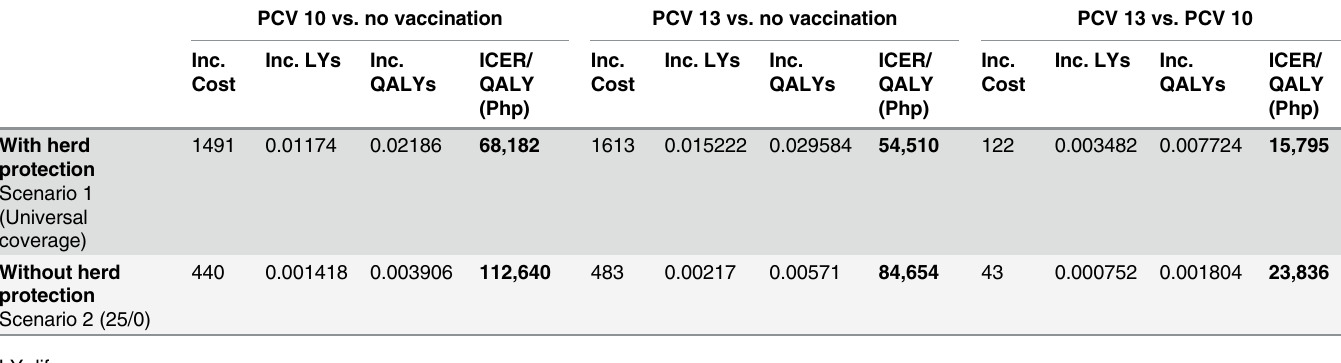
Table 3. Incremental outcomes of introducing PCV10 and PCV13 compared to no